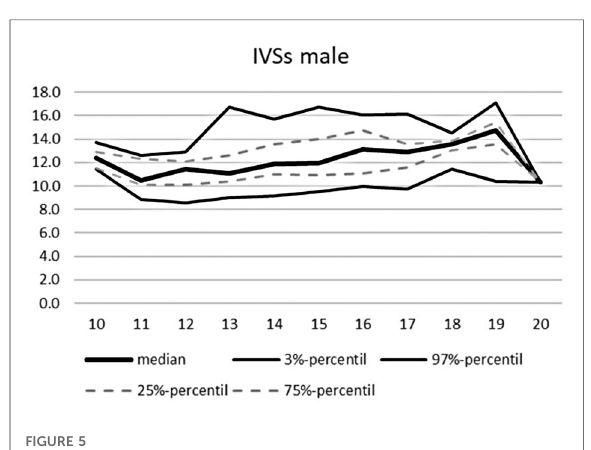
FIGURE 8 Echocardiographic values in dependence of age, IVSd female.